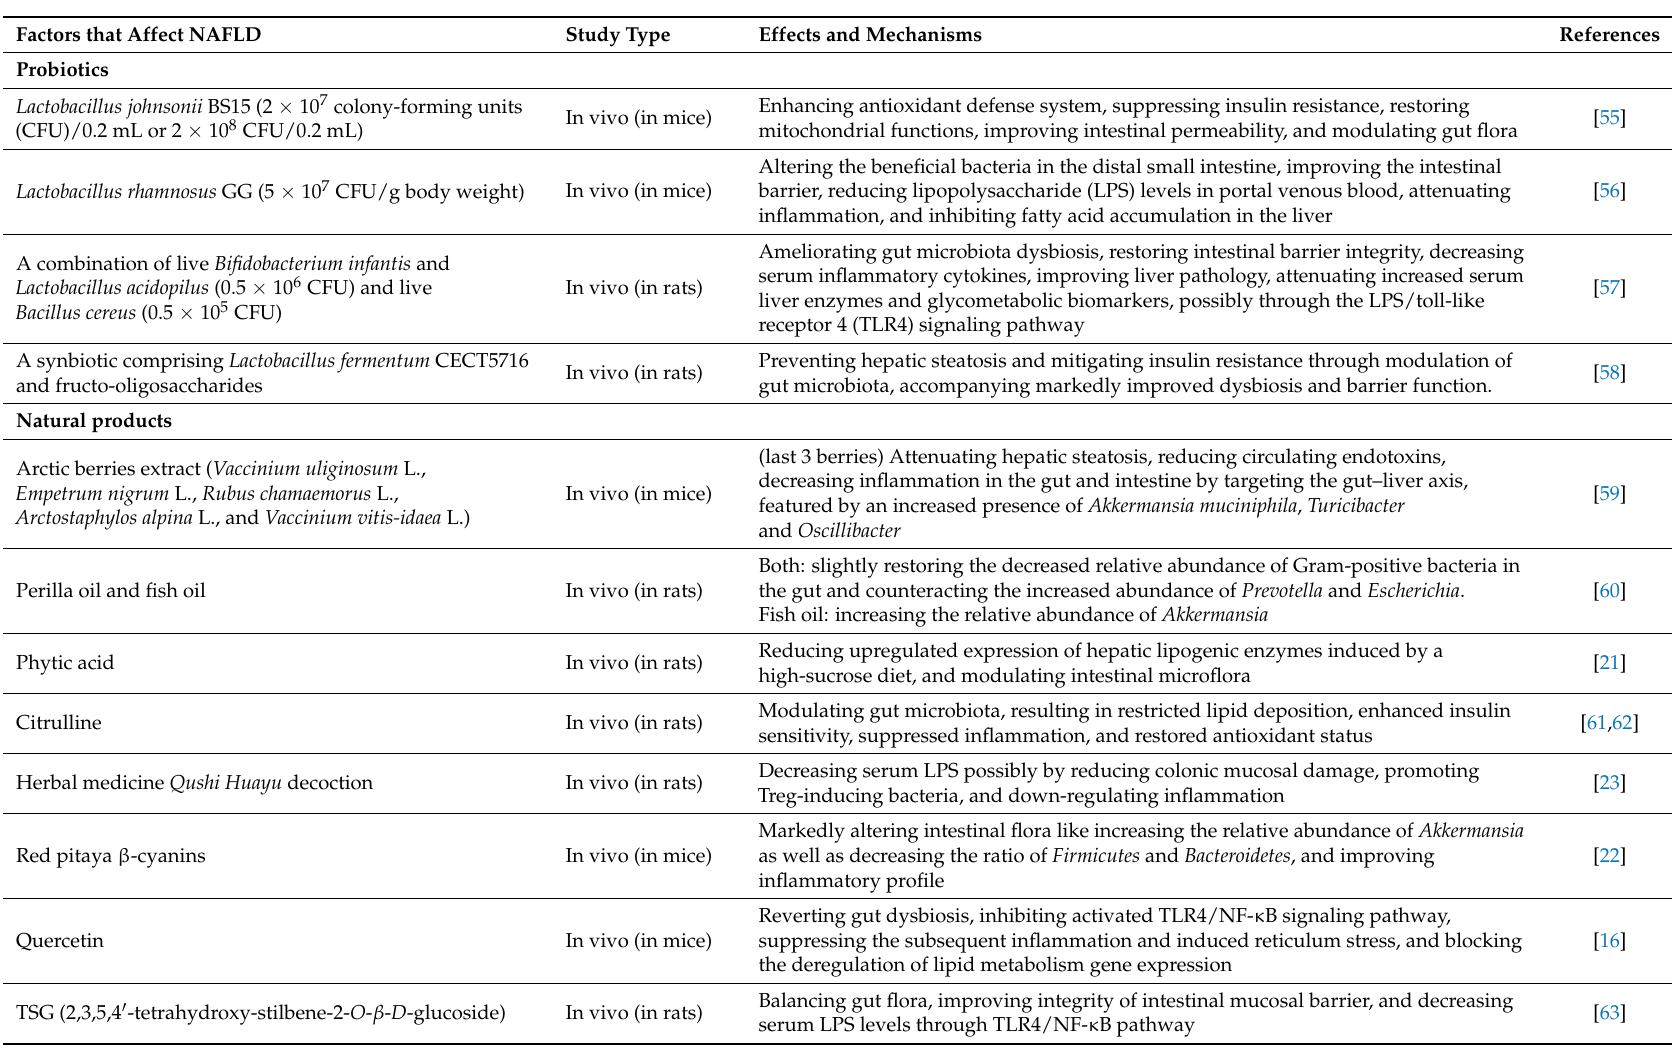
Table 1. Effects and mechanisms of natural products and probiotics on non-alcoholic fatty liver disease (NAFLD) by modulating gut